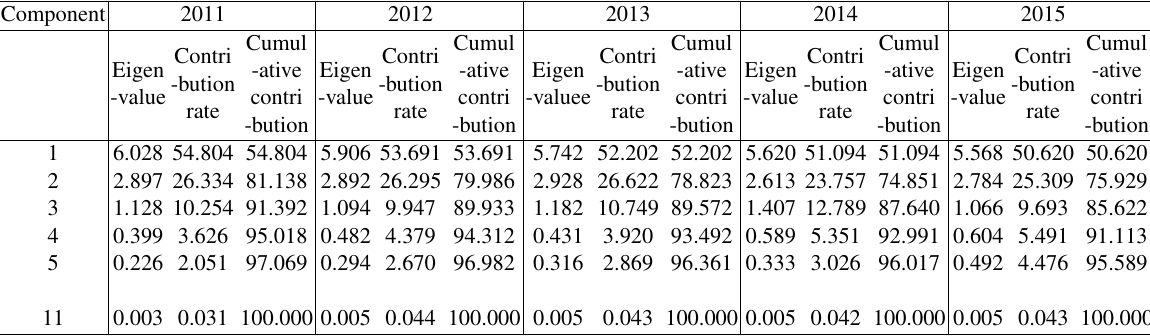
Table 2. Eigenvalues and variance contribution rates of the principal component